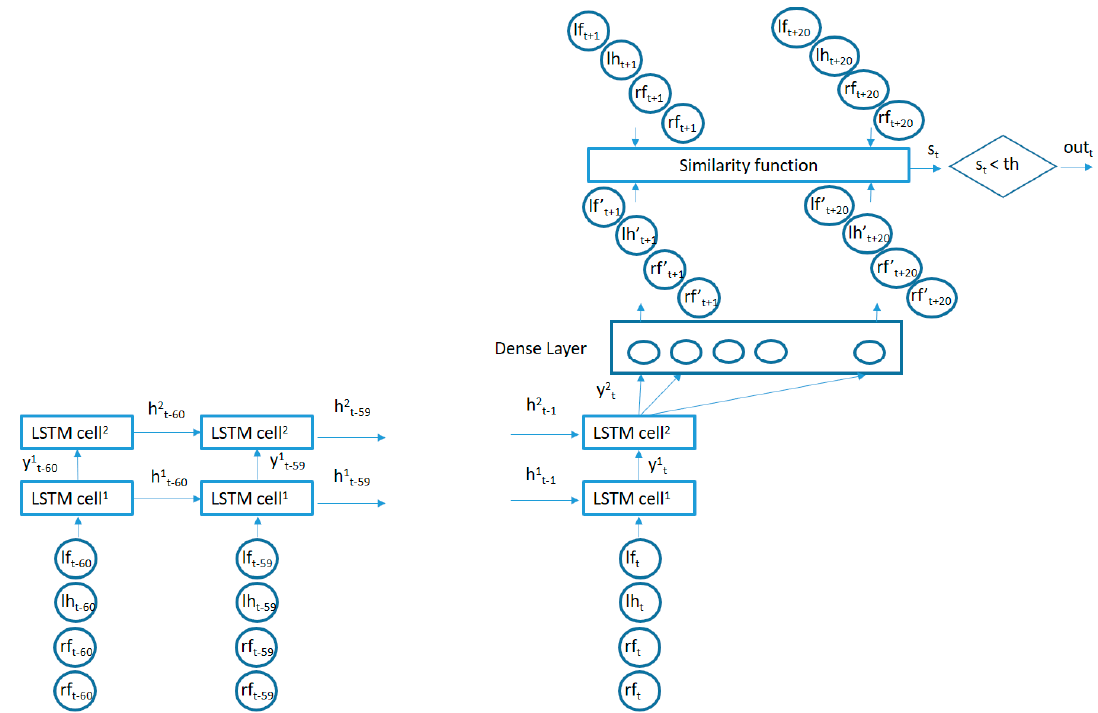
Figure 4. Proposed algorithm.